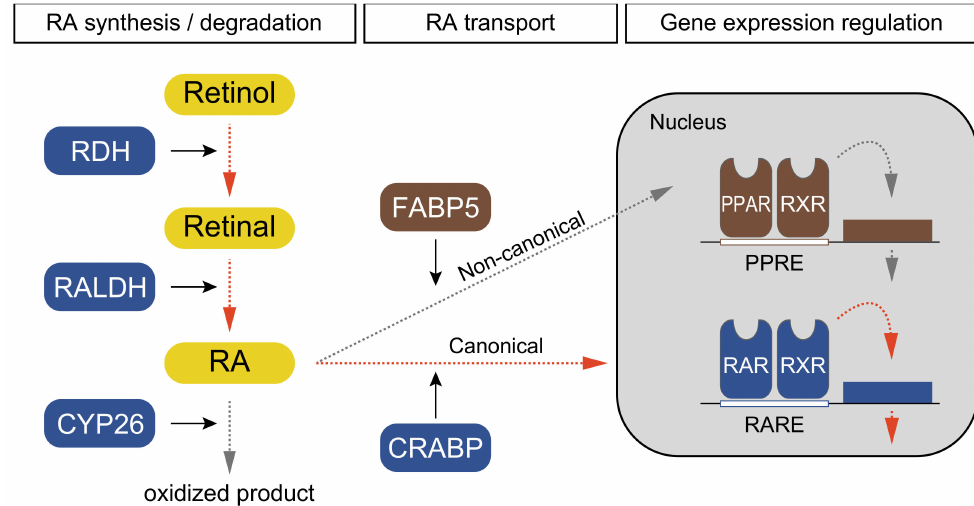
Figure 1. Schematic pathway and components of retinoic acid (RA) signaling in echinoderms. The signaling pathway is divided into three steps: RA synthesis/degradation, RA transport, and gene expression regulation. Dotted arrows indicate the direction of signaling transduction; orange and gray indicate canonical and non-canonical pathways, respectively. Squares indicate enzymes and retinal derivatives; blue, brown indicate enzymes with canonical and non-canonical pathways, respectively, and yellow indicates retinol derivatives. Solid arrows indicate enzyme functions. Table 1. Resource of genomic and transcriptomic data of echinoderms. We investigated transcriptome data for the starfish Patiria pectinifera [9], the sea cucumber Apostichopus japonicus [13], the brittle star Amphiura filiformis [14] and the sea lily Metacrinus rotundus [15]. We also used genomic data for the sea urchin Strongylocentrotus purpuratus [16], and the sea cucumber A. japonicus